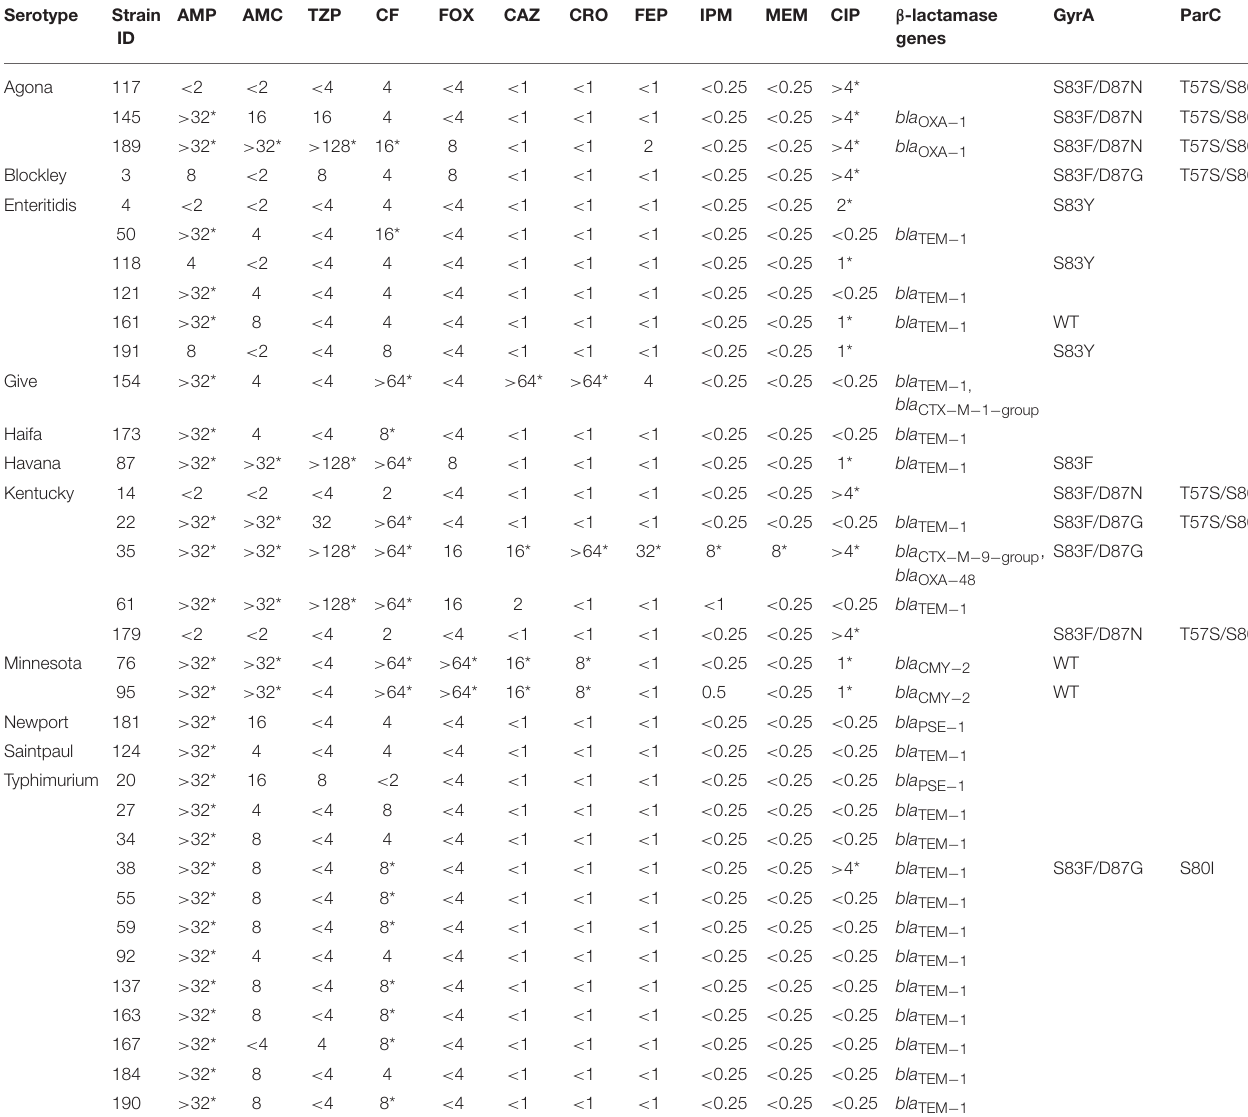
TABLE 7 | Genotypes for Salmonella strains with resistance to β -lactam antibiotics and Ciprofloxacin. Serotype Strain AMP AMC TZP FOX β -lactamase ID